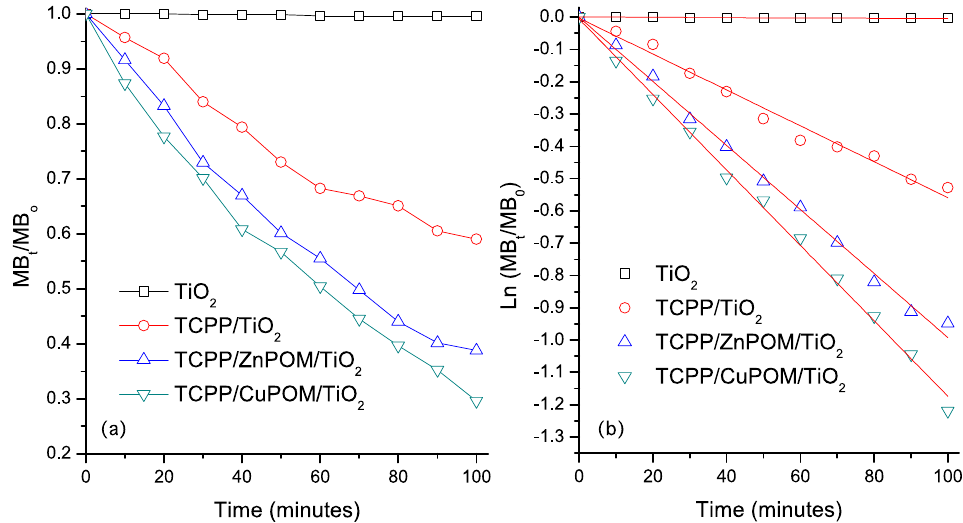
Figure 7. ( a ) Methylene blue (MB) concentration vs. time of visible irradiation. ( b ) Experimental data fitting with the Langmuir–Hinshelwood